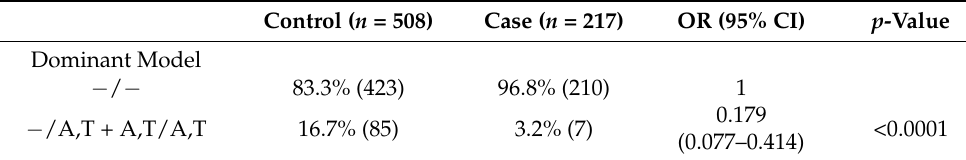
Table 9. Logistic regression analysis of the association of LPL rs274 with CHD adjusting for age and sex in 725 Kuwaiti